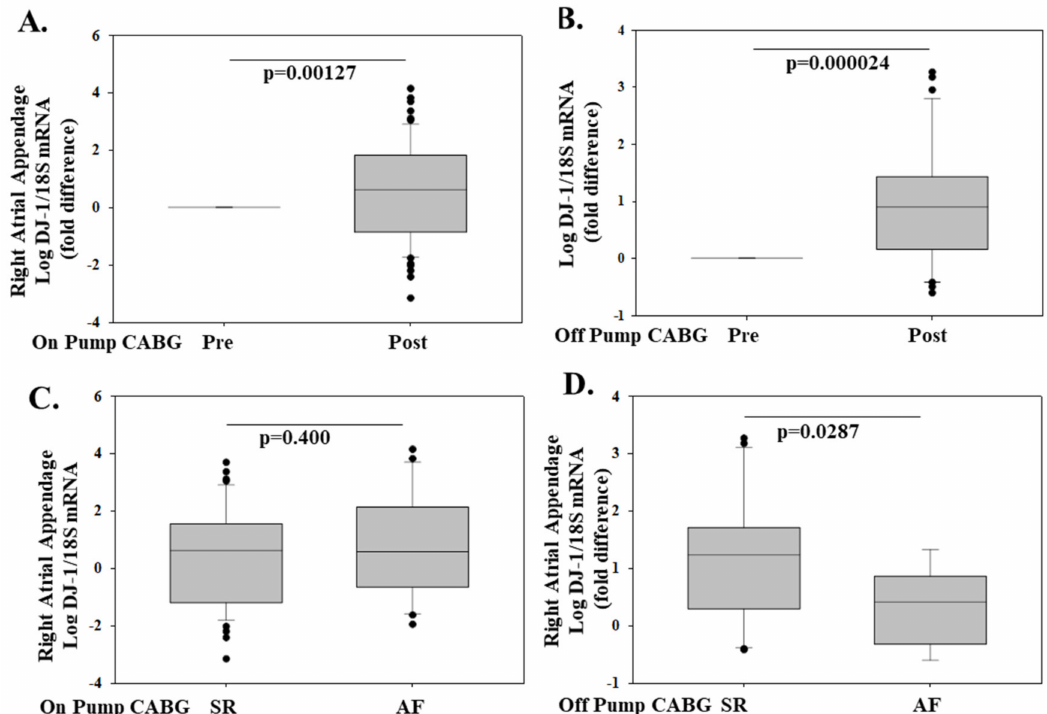
Figure 5. Right atrial appendage (RAA) DJ-1 mRNA is increased post-on and -off CABG specifically in off-pump patients that remain in sinus rhythm (SR). This prospective study examined 67 patients (44 males and 23 females, mean age 64.1 ± 1.13 years) that underwent elective on-pump coronary artery bypass grafting (CABG) and 31 patients (28 male and 3 females, mean age 64.1 ± 1.53 years) that underwent elective off-pump surgery. Inclusion criteria were as follows: (1) preoperative SR; (2) elective CABG. Exclusion criteria were as follows: (1) history of AF/flutter; (2) history of prior